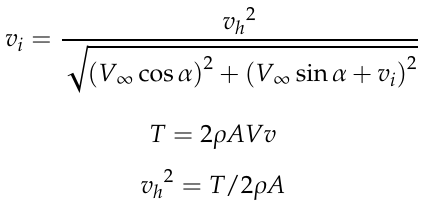
Figure 2. Flow model of momentum theory analysis for the isolated rotor.